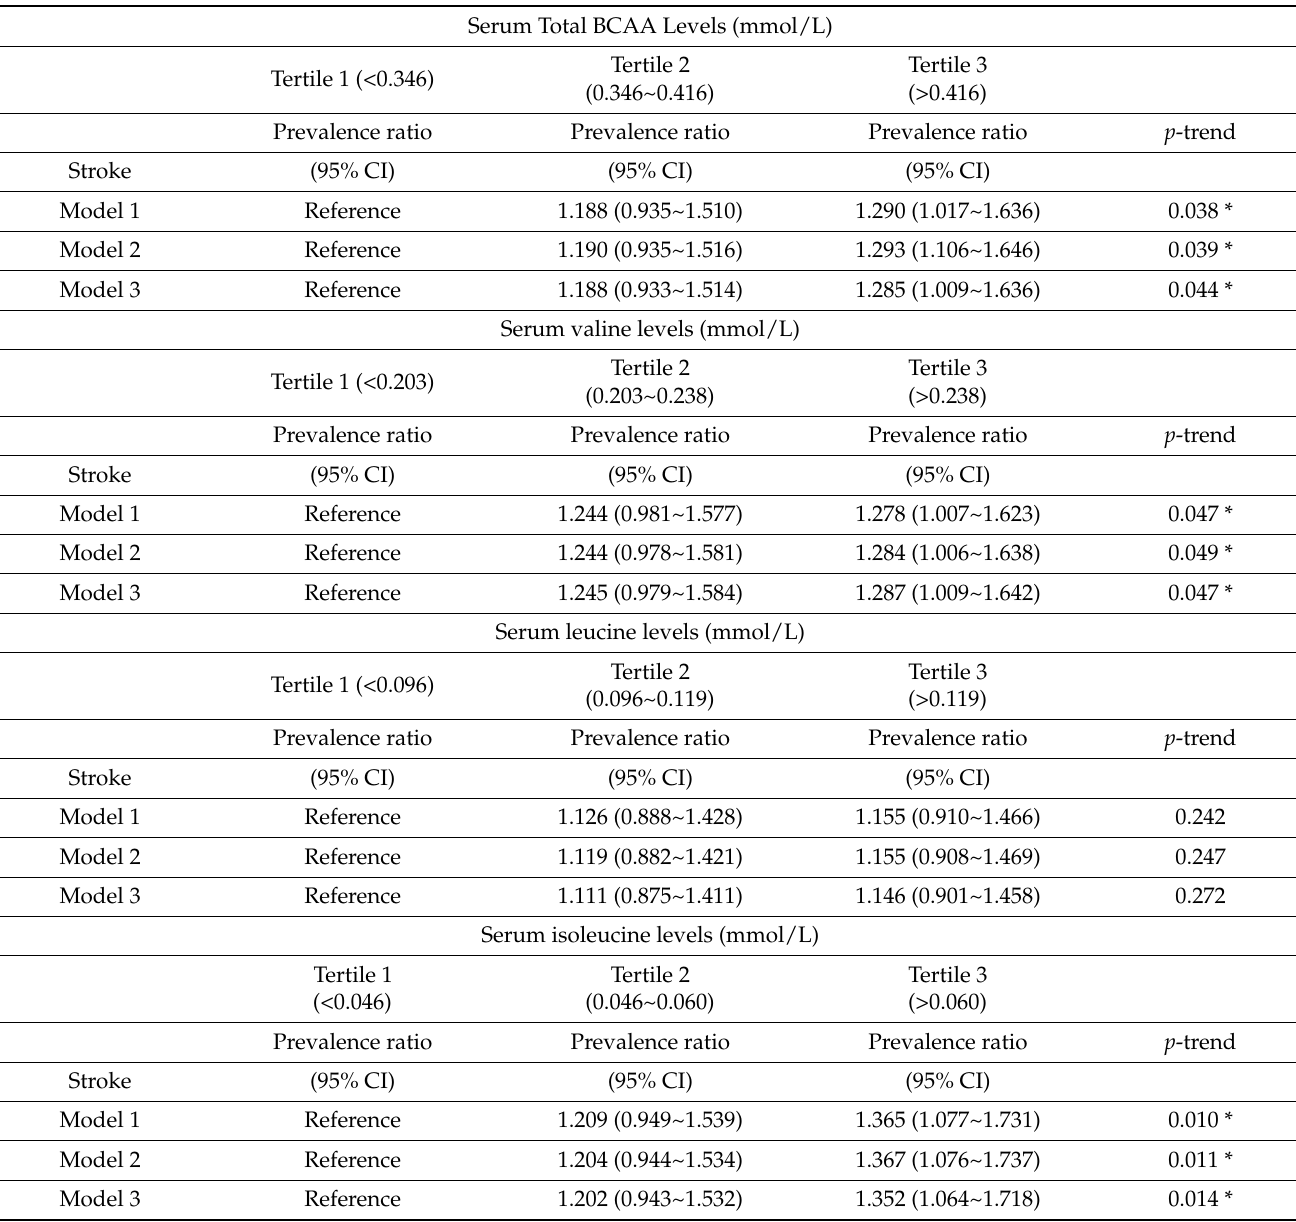
Table 1. Association of baseline circulating BCAAs and the risk of multiple cardiovascular